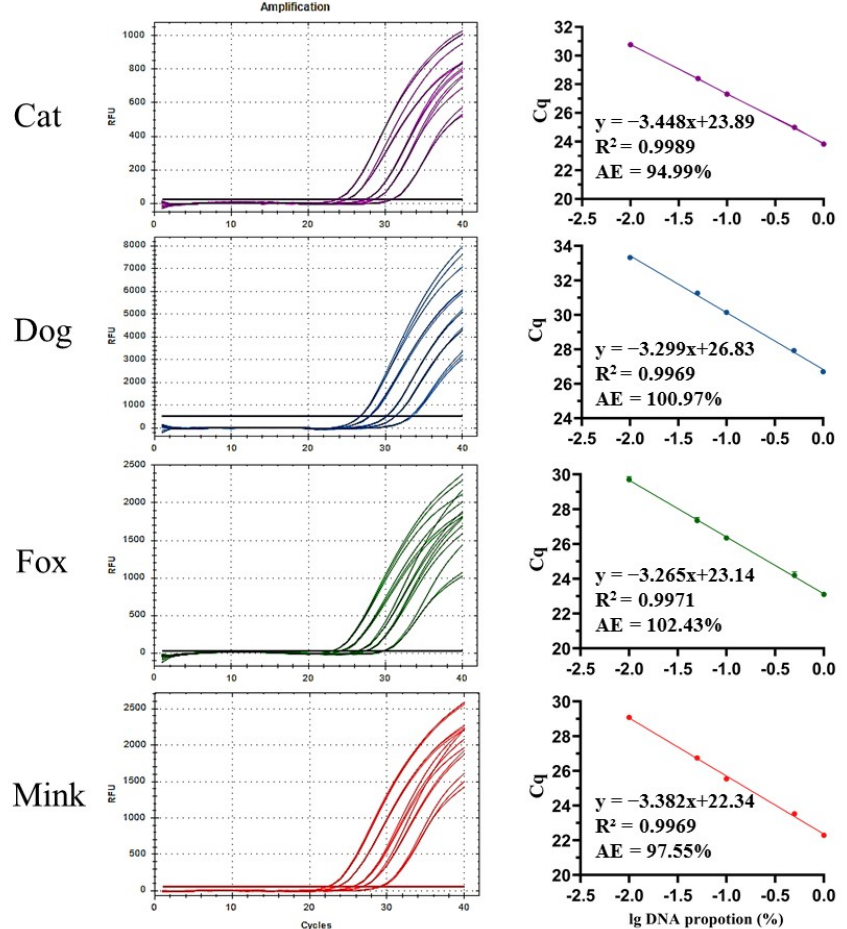
Figure 6. Standard curves of UP-M-rtPCR for quantitative analysis of varying DNA proportions of cat, dog, fox, or mink (1%, 5%, 10%, 50%, and 100%). Table 2. UP-M-rtPCR quantification of cat, dog, fox, and mink content in DNA mixtures. DNA